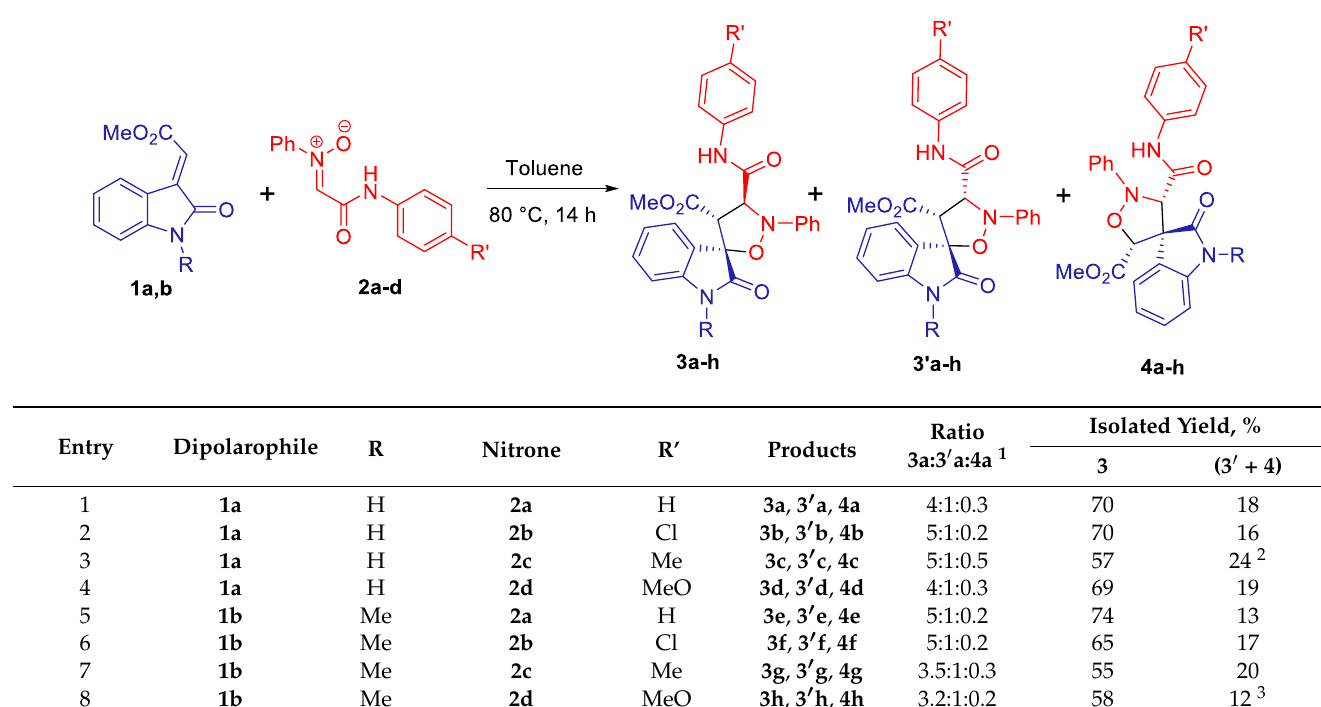
1 — from 1 H NMR spectra of the crude reaction mixtures. 2 — 8% of the ( 3 ′ c + 4c ) mixture and 16% of pure 3 ′ c . 3 — pure 3 ′ h .